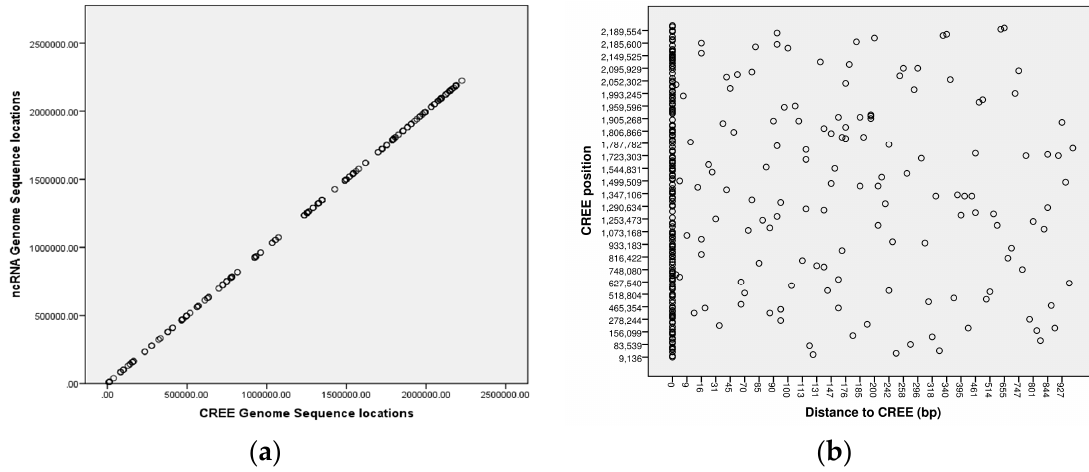
Figure 1. Statistical analysis of the associations between CREE and predicted ncRNAs. ( a ) Using SPSS, CREE locations in N. gonorrhoeae strain NCCP11945 were tested for a normal distribution using the Kolmogorov-Smirnov test. Non-parametric Spearman’s Rho correlation analysis was employed to determine correlation between CREE locations ( x -axis) and the SIPHT predicted ncRNA genome sequence locations ( y -axis). ( b ) Statistical analysis of the start/end points of the CREE and the start/end points of the SIPHT predicted ncRNAs shows a close association of these elements in the chromosome. On the x -axis is plotted the distance of the ncRNA to the CREE in basepairs, while on the y -axis are the CREE positions along the N. gonorrhoeae strain NCCP11945 chromosome. This shows that the majority of the CREE are overlapping ncRNAs.